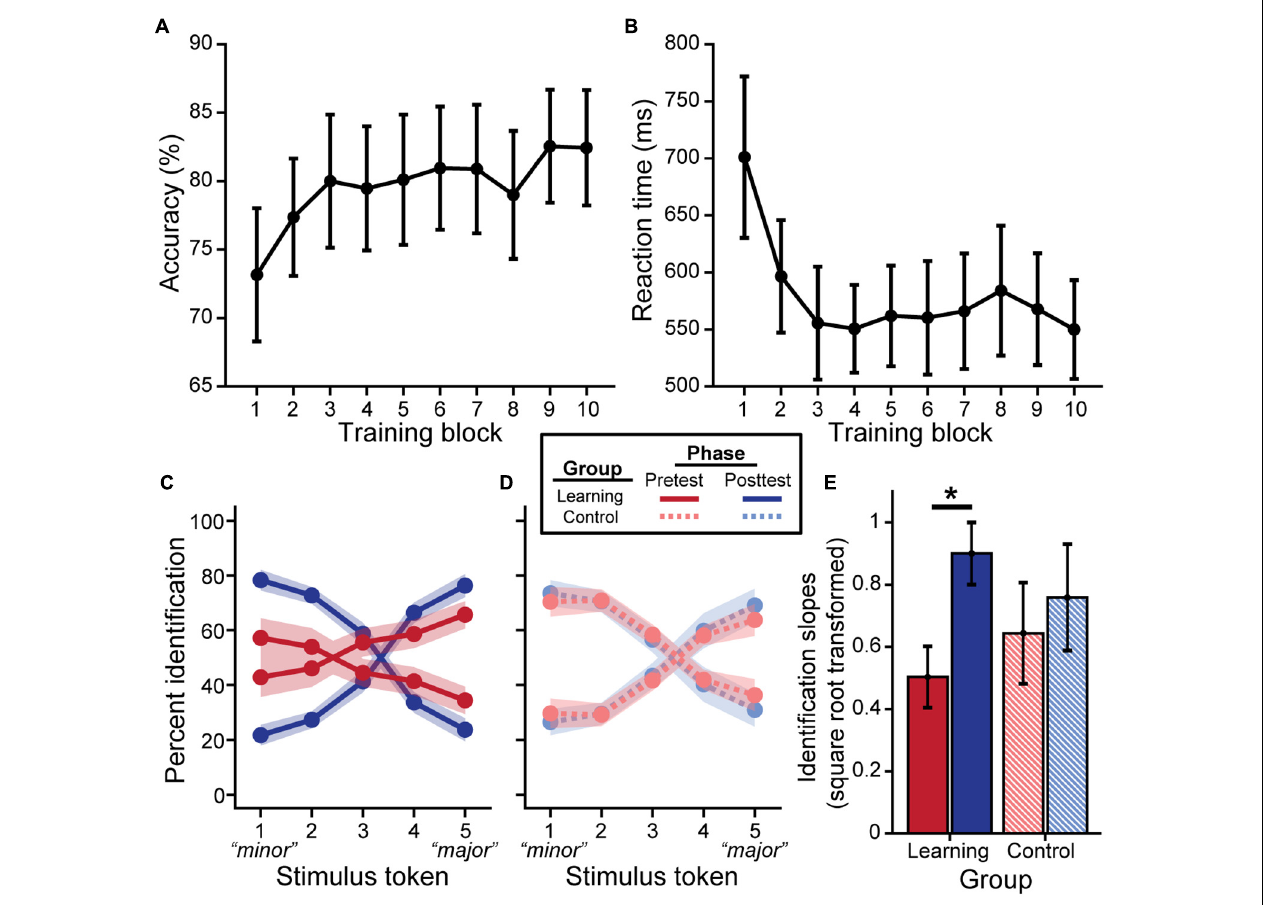
FIGURE 2 | Behavioral categorization improves following rapid auditory training. Brief major/minor categorization training yields an increase in accuracy (A) and decrease in reaction time (B) across blocks. Pretest and posttest psychometric identification functions for the learning group (C) show stronger categorization for musical intervals after training (excluding data from n = 5 non-learners); performance was identical pre- to post-test for control listeners (D) . Slopes were square-root transformed for statistical analysis (E) . Error bars/shading = ± 1 SE. * p <